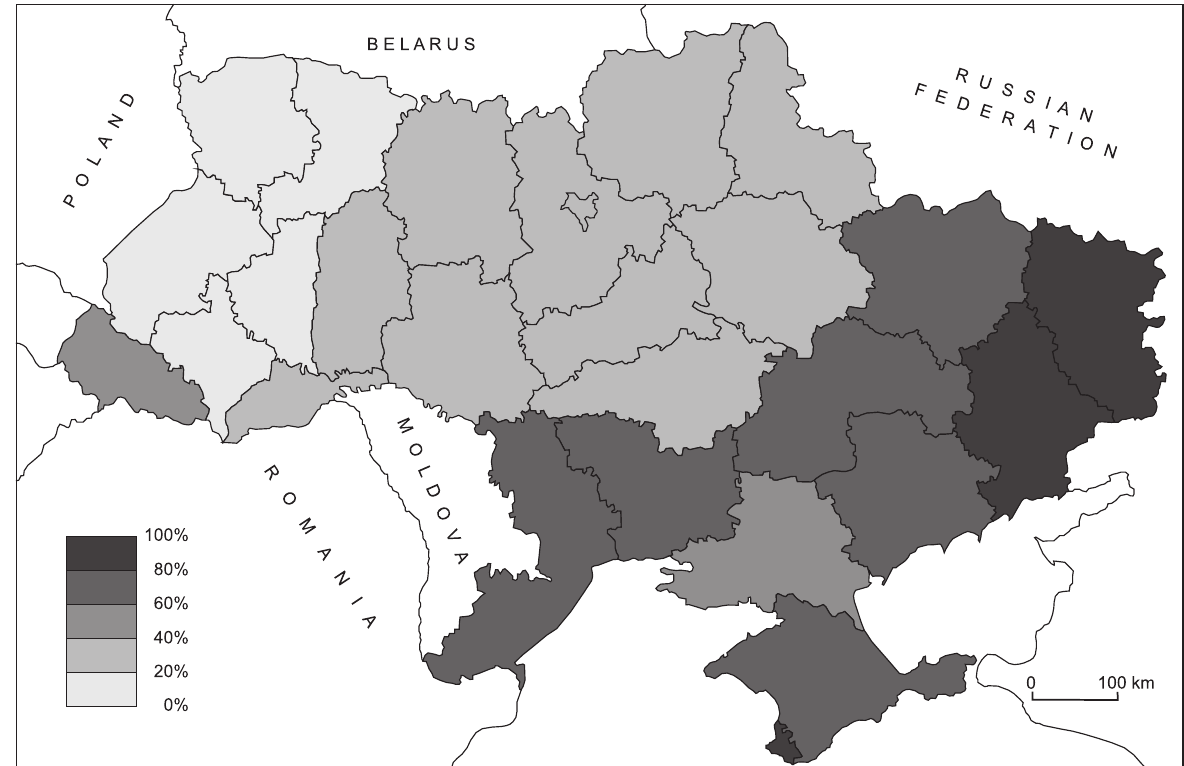
Fig. 4. Percentage of votes in Yanukovych’s support at the 2010 presidential election Source: http://www.cvk.gov.ua/pls/vp2010/WP0011